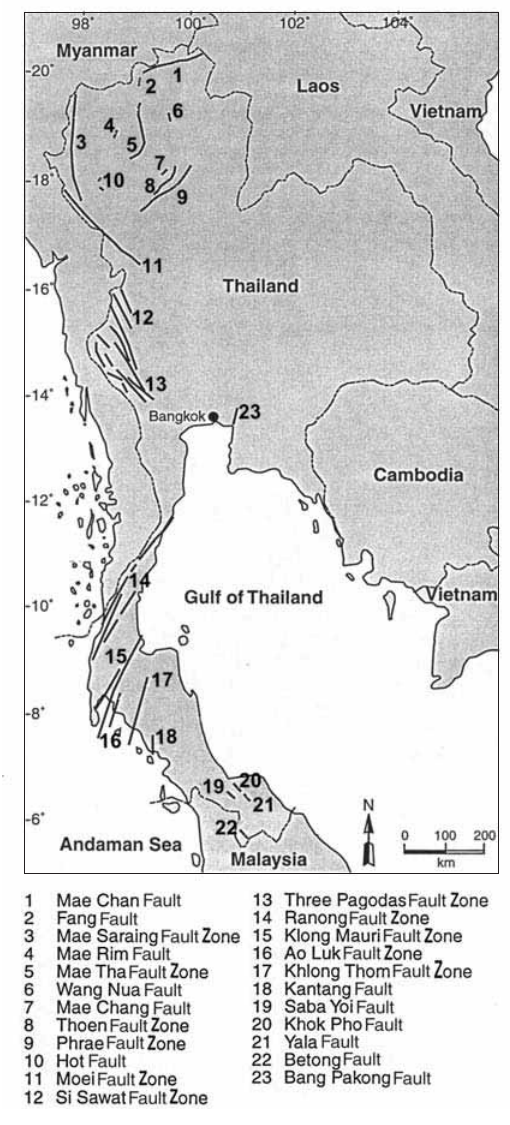
Fig. 4. Active and suspected active faults in Thailand. Modified from Hinthong